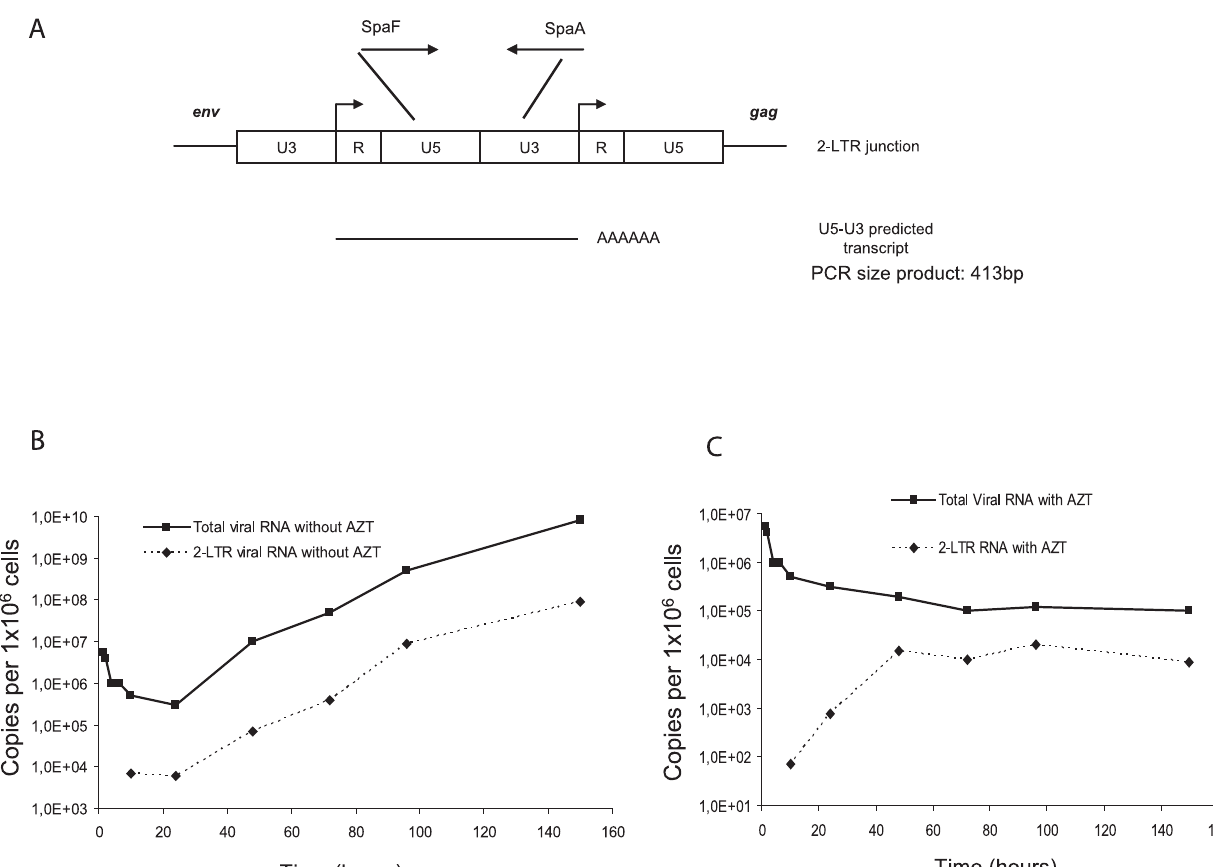
Figure 4. Transcriptional activity of 2-LTR circles. Primers used for the quantification of U5-U3 transcript are indicated. ( A ). The U5, R, U3 regions of the 2-LTR circles are represented. Arrowheads indicate transcription start sites. Kinetics of total viral RNA as well as U5-U3 transcript